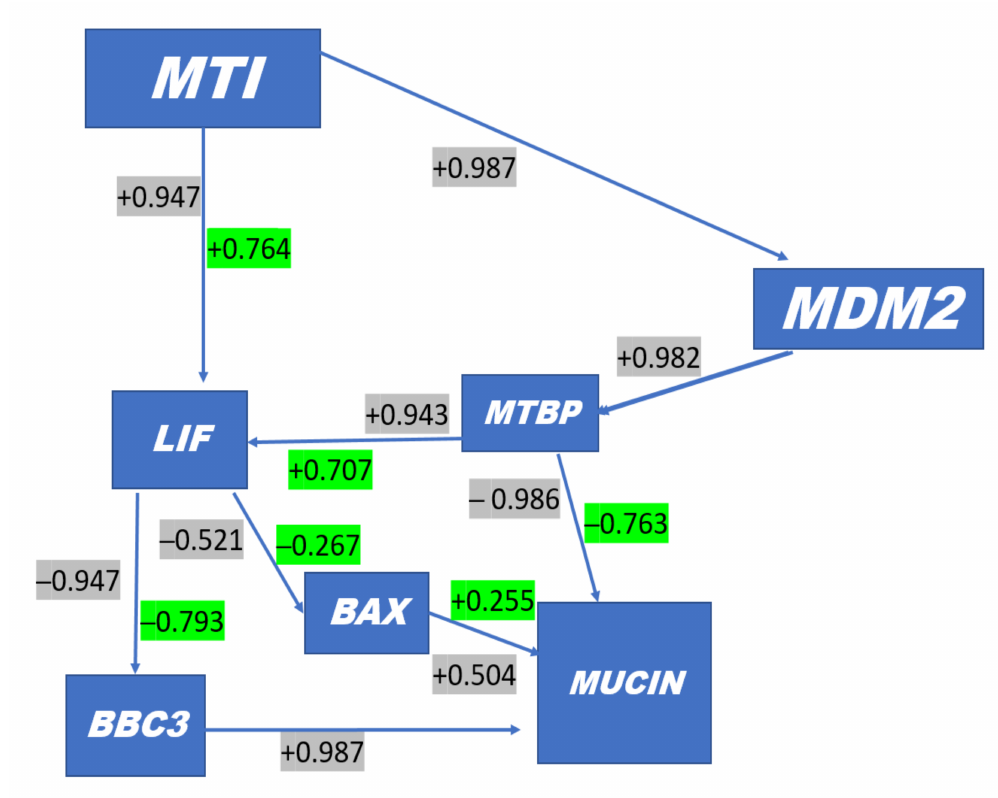
Figure 4. Simple (Gray) and Standard Partial correlations (Green) in uterine luminal endometrial cells responsive to ISG 15 expression in blood cells. Based on magnitude of decrease in correlation between simple and partial correlations, the systems in cellular target components are modulated by ISG15 e.g., MTBP with Mucin is highly correlated negatively but when adjusted to average ISG15 expression the relationship is reduced, which indicates that ISG15 targets MTBP . In contrast, MDM2 MUC1 and adjusted for ISG15 , the correlation is not reduced but it stays the same. + MT1